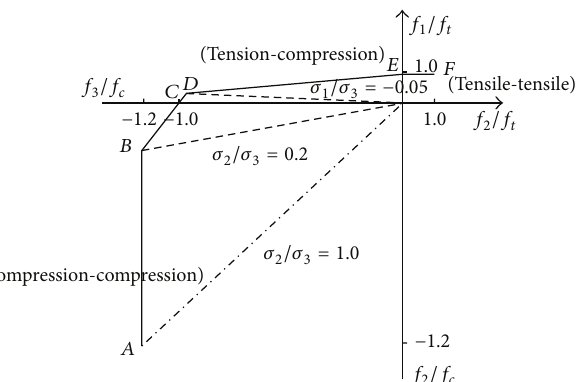
Figure 5: Biaxial strength envelope diagram of the concrete [17].